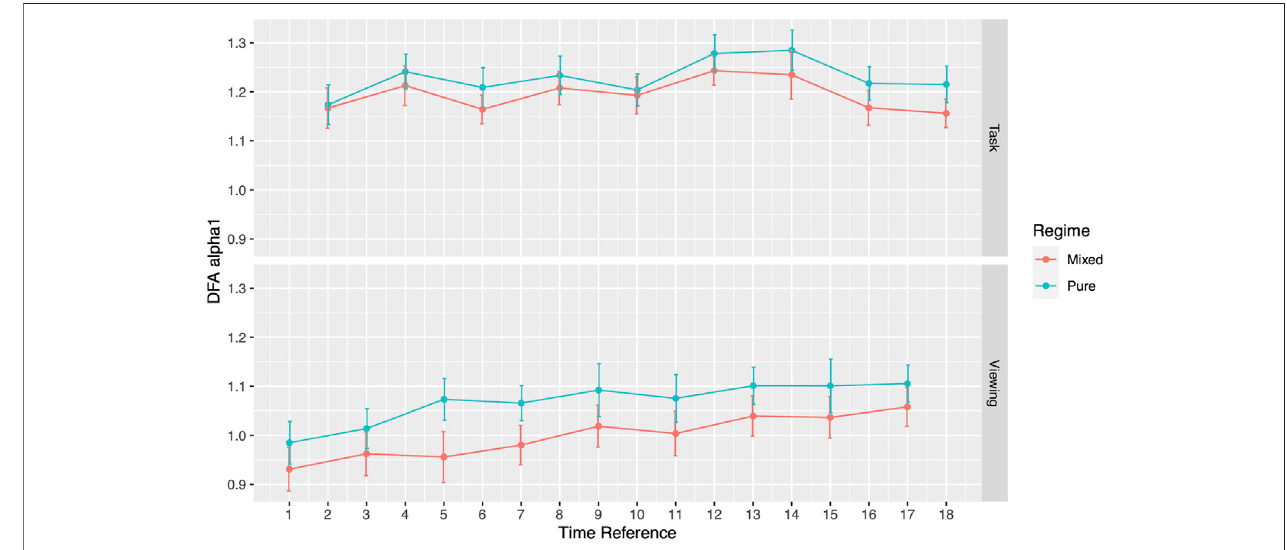
FIGURE 2 | DFA α 1 for the two image regimes during each